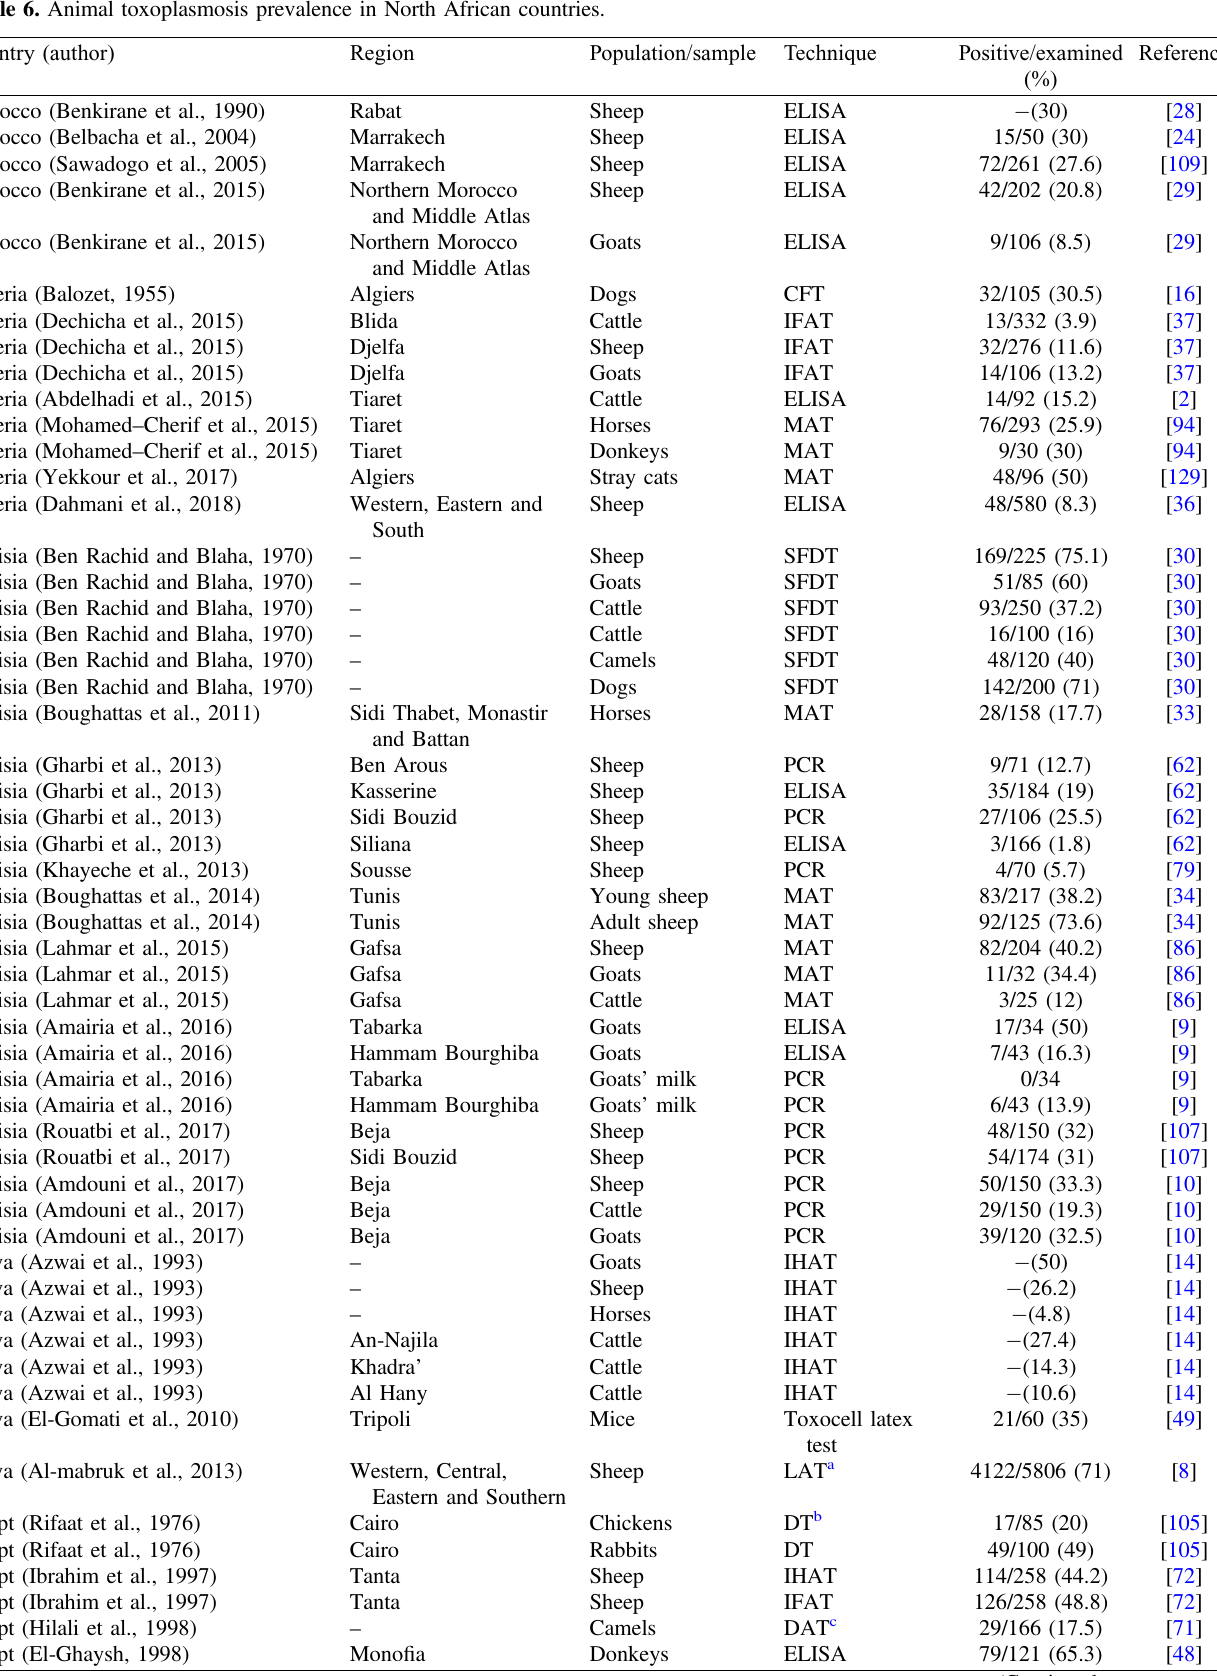
Table 6. Animal toxoplasmosis prevalence in North African countries. Country